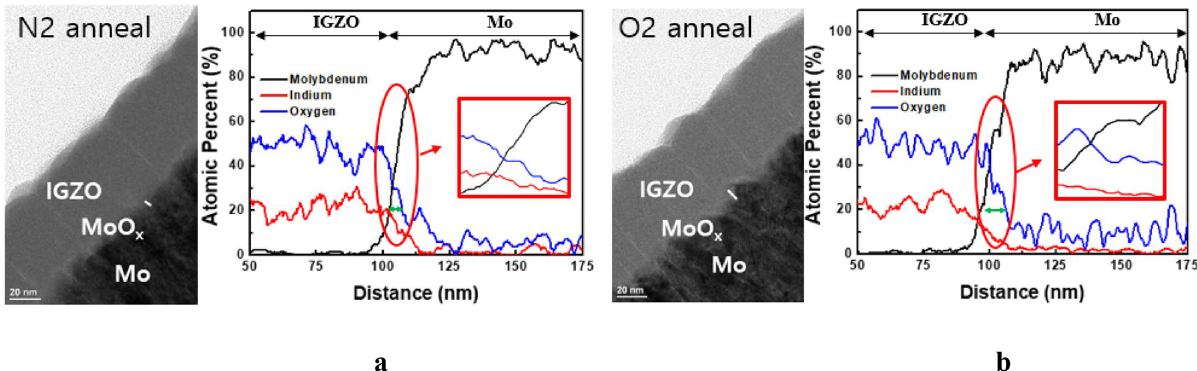
Figure 3. HR-TEM images for Mo-IGZO interface annealed at 350 °C, under the nitrogen atmosphere ( a ), and oxygen atmosphere ( b